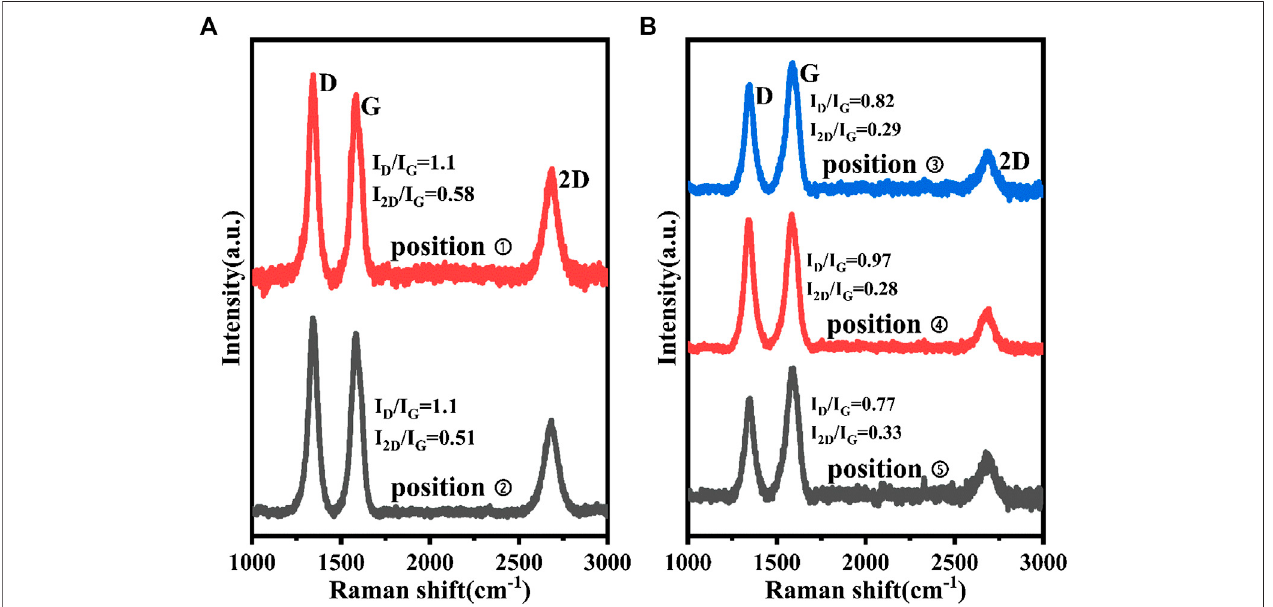
FIGURE 6 | Raman Spectra of (A) positions one and two, (B) positions three, four, and fi ve in Figure 5 .